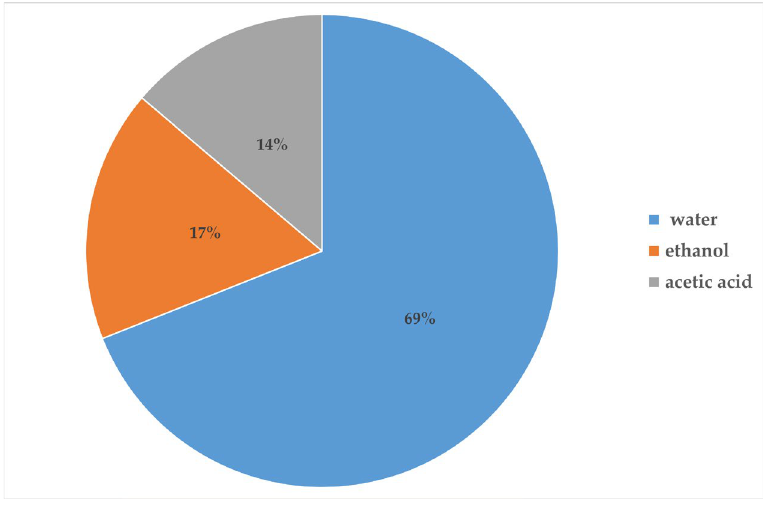
Figure 3. Pie chart of solvents used for electrospinning of water-soluble synthetic polymers de-scribed in this review.